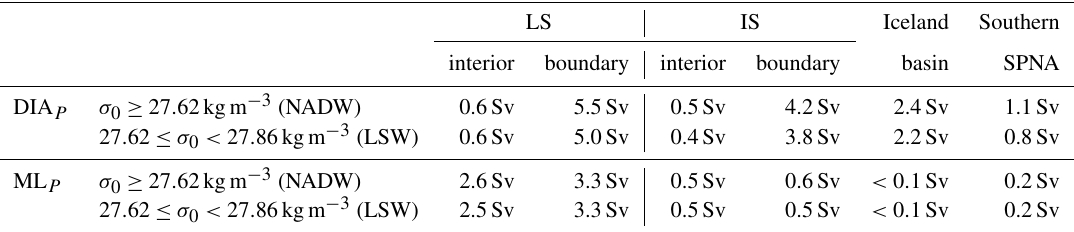
Table 2. Mean transport contributions (2010–2019) from the Labrador Sea (LS) and Irminger Sea (IS), the Iceland basin, as well as the remaining SPNA south of 52 ◦ N (southern SPNA) in Sv. The regions are outlined by the dashed–dotted blue lines in Fig. 1. The Labrador and Irminger Sea contributions are separated into an interior and boundary component (water depths shallower than 3000m in the Labrador Sea and 2000m elsewhere). Transport contributions are given for DIA P and ML P (see Sect. 2.1.3 for details of the definitions). Values are given for σ 0 ≥ 27 . 62kgm − 3 (NADW) and 27 . 62 ≤ σ 0 < 27 . 86kgm − 3 (LSW); the difference between the two corresponds to the transport associated with σ 0 ≥ 27 . 86kgm − 3